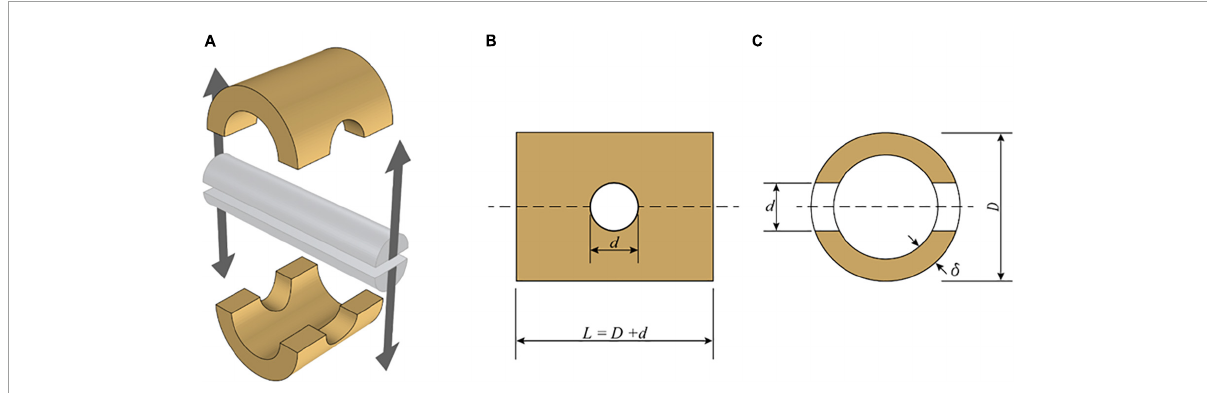
FIGURE2 Schematic view of split-pin apparatus modified from ISO 2019. (A) Split-pin apparatus. (B) Side elevation of a specimen. (C) Section through the